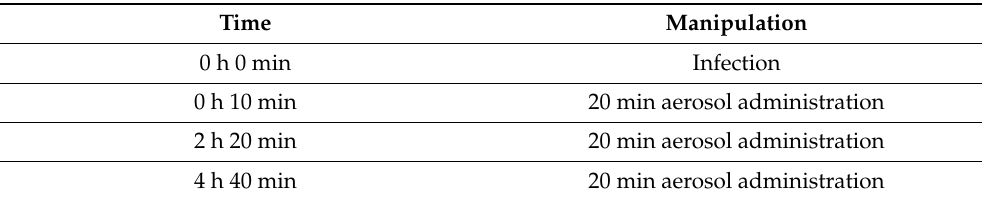
Table 7. Infection–treatment manipulations with the mice of Aerosol group. Time